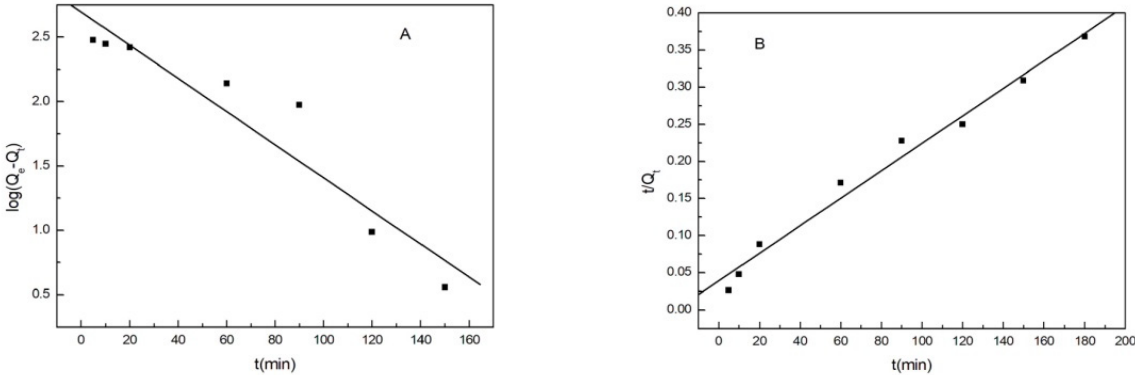
Figure 10. Adsorption kinetics of Cu(II) ions on MML: ( A ) pseudo-first-order kinetic, ( B ) pseudo- second-order kinetic. Table 2. The data of Cu(II) ions adsorption on MML obtained by two models. Q e* /mg · g −